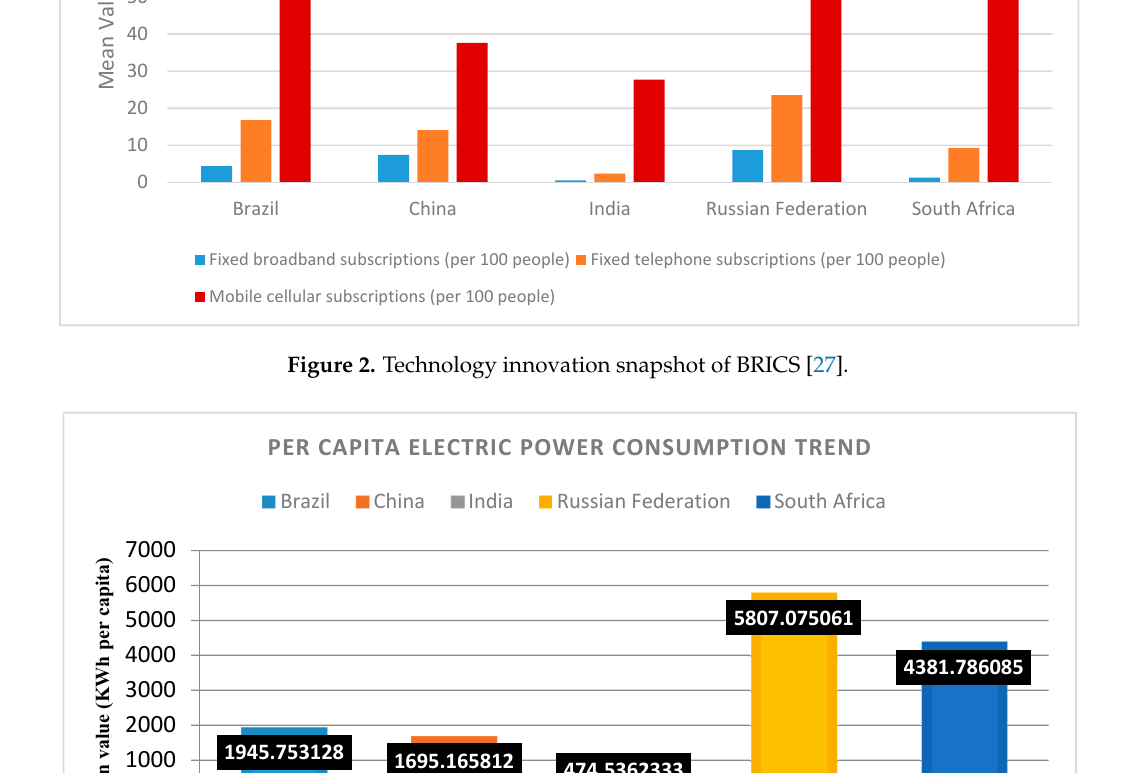
Figure 2. Technology innovation snapshot of BRICS [27].